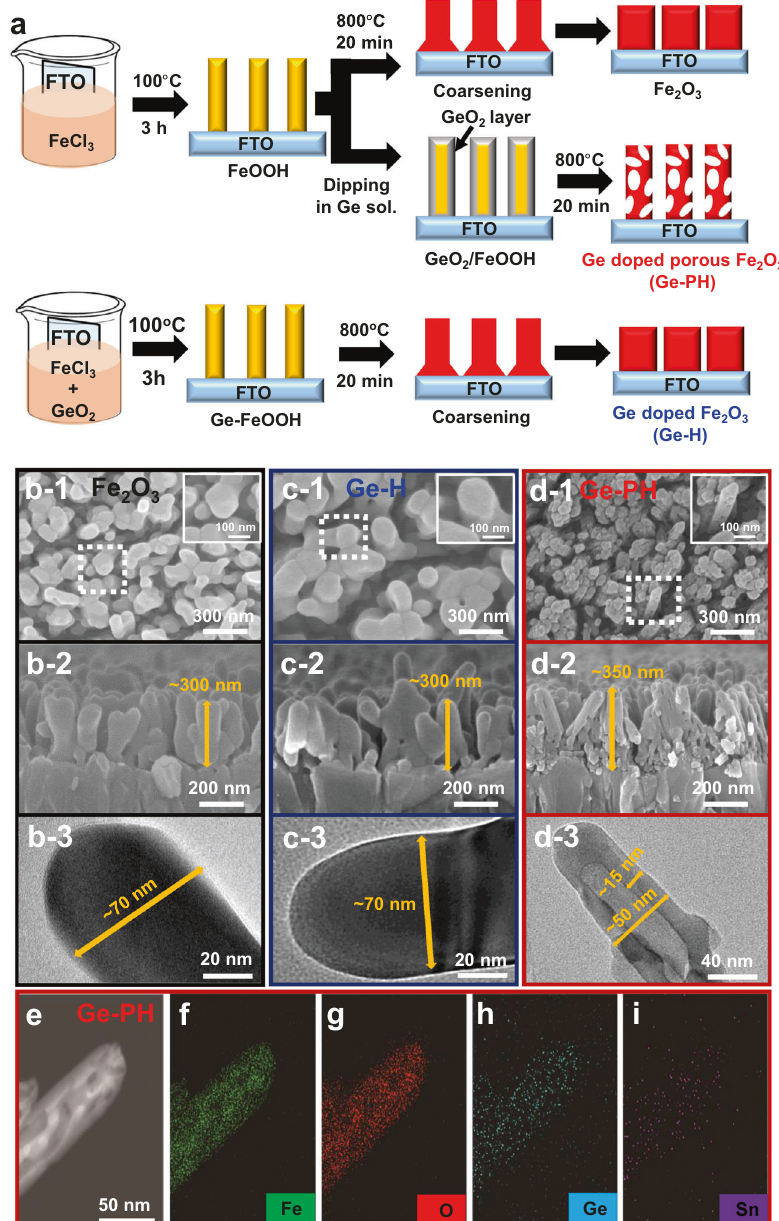
Fig. 1 Fabrication process and morphology of Ge-PH. a Scheme for fabrication of the Fe 2 O 3 , Ge-H, Ge-PH. b Scanning electron microscopy (SEM) and transmission electron microscopy (TEM) images (top-view (b-1, c-1 and d-1), cross-section (b-2, c-2 and d-2) and TEM image (b-3, c-3 and d-3)) of b Fe 2 O 3 , c Ge-H and d Ge-PH. e Scanning transmission electron microscopy (STEM) image of Ge-PH and the corresponding elemental mapping of f Fe, g O, h Ge and i